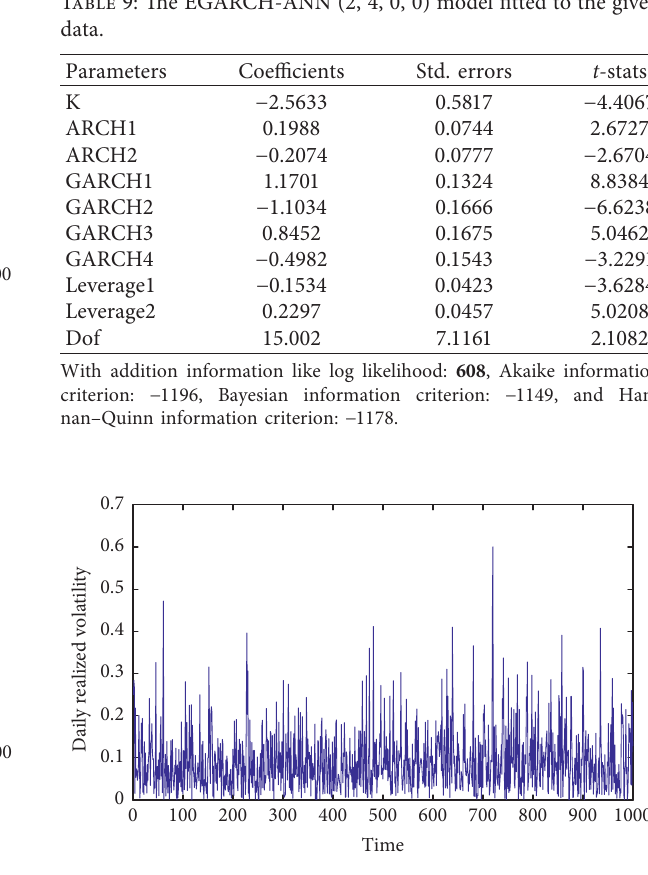
Figure 17: The realized volatility from the simulated residual